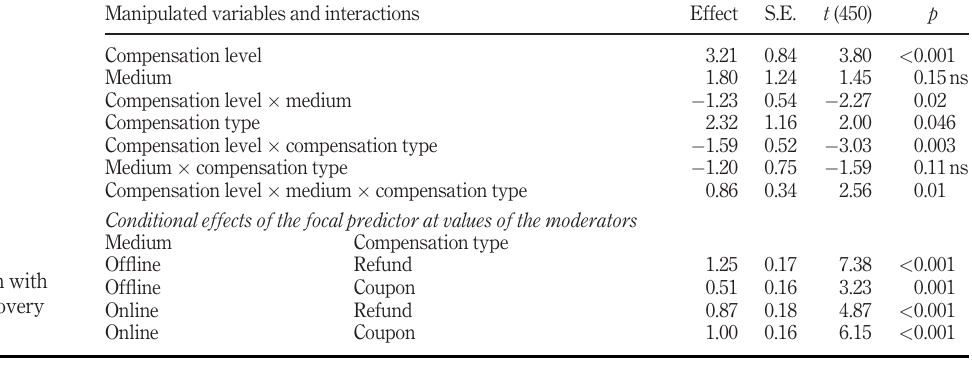
Manipulated variables and interactions